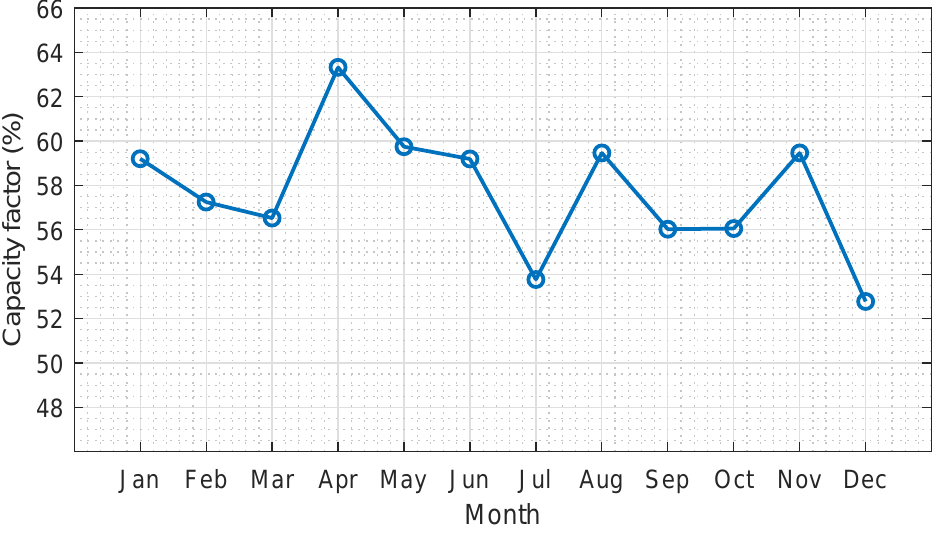
Figure 7. Variation of capacity factor by month.